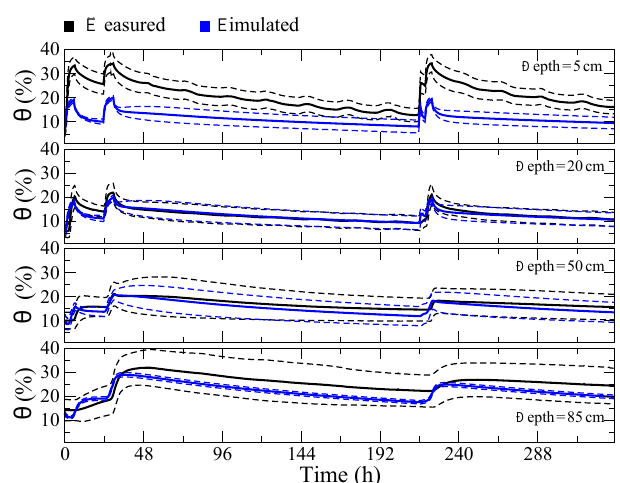
Figure 11. Averaged θ profiles at 5, 20, 50, and 85cm depths from the surface. In each graph the deviation from the mean (1 standard deviation above and below) is shown as dashed lines. The results are obtained for simulation f reported in Table